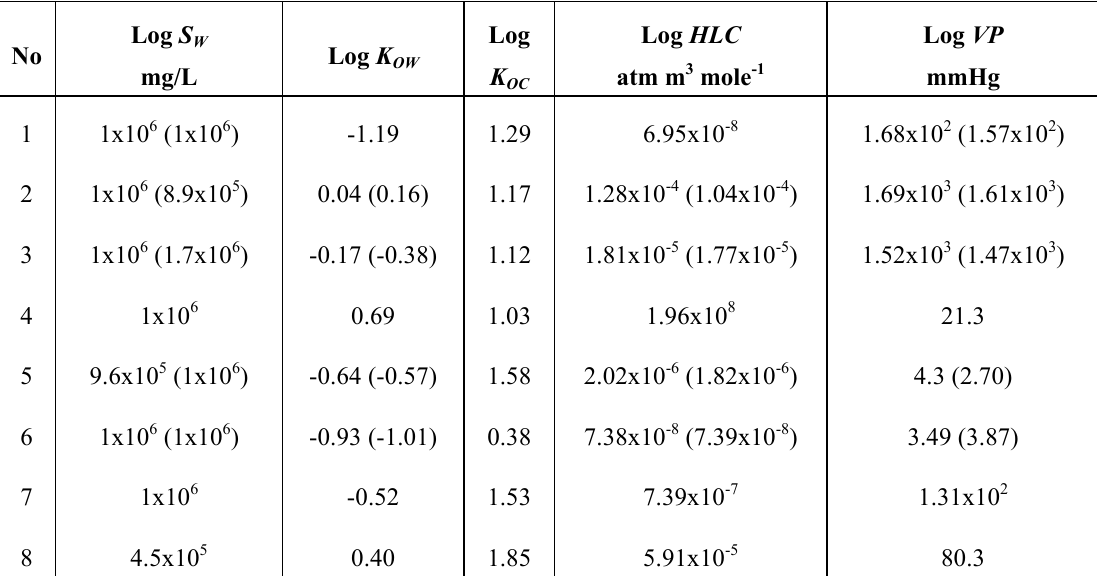
Table 1 . Calculated and experimentally determined physico-chemical parameters for the investigated substances a